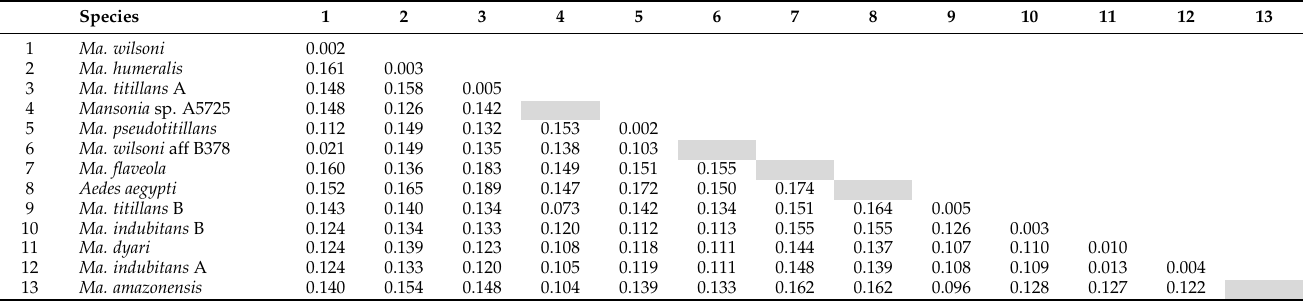
Table 3. Mean interspecific (below the diagonal) and intraspecific (along the diagonal) distances for COI sequences. Distances were calculated using the Kimura 2-parameter distance